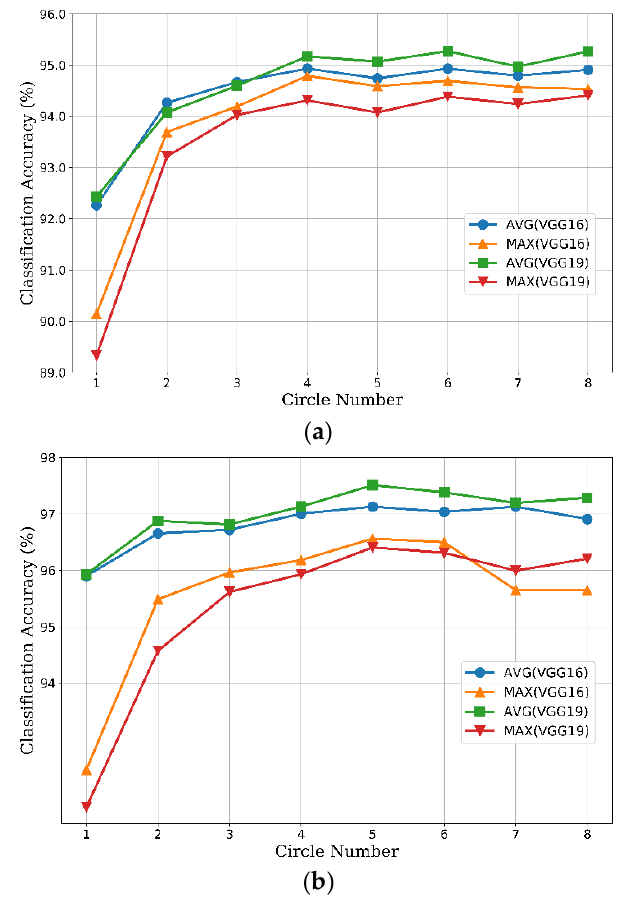
Figure 8. The classification accuracy of concentric circle pooling network as a function of circle number. The AVG and MAX in the labels indicate the average aggregate and max average. ( a ) The UC Merced dataset; ( b ) The WHU-RS dataset.